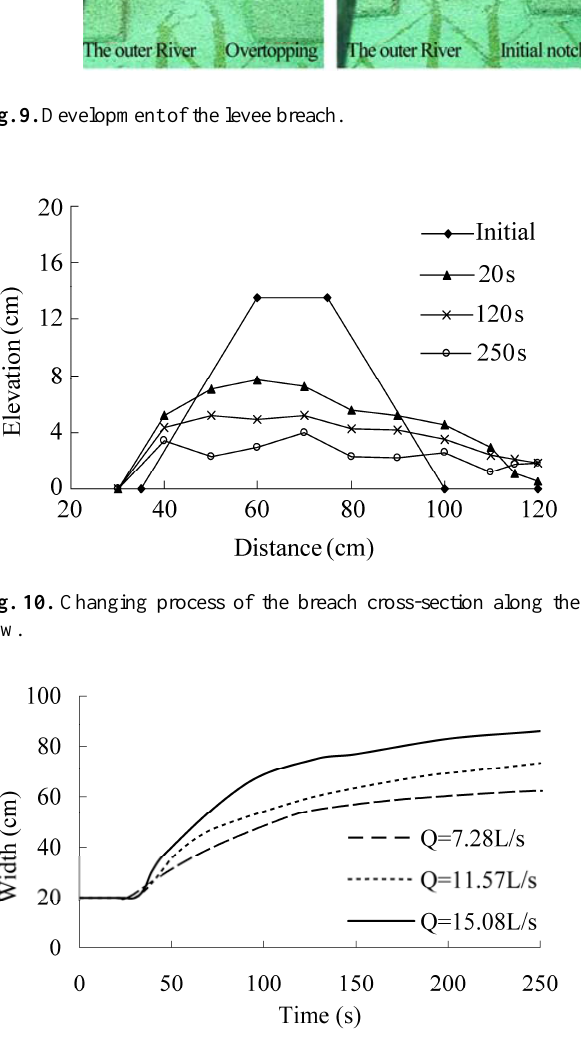
Fig. 9 Development of the levee breach.